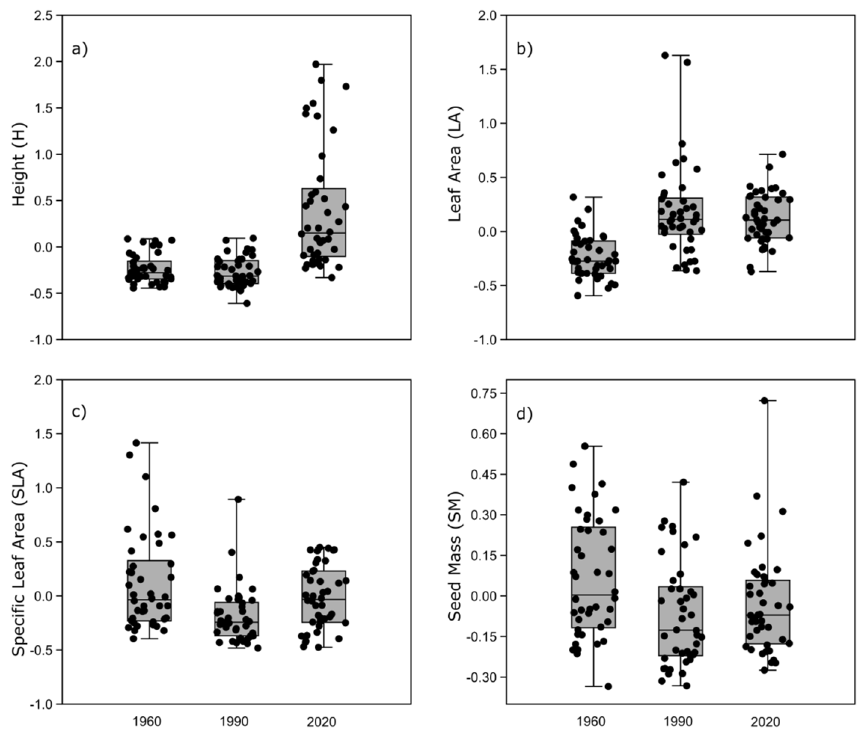
Figure 7. Summary box-and-whisker plots with jitters presenting changes in CWMs for analyzed functional traits of herb layer species between three studied surveys of the riparian forest in the Odra River Valley (SW Poland). The central line of each box indicates the median value, box boundaries the lower (25%) and upper (75%) quartiles, and whiskers the range of